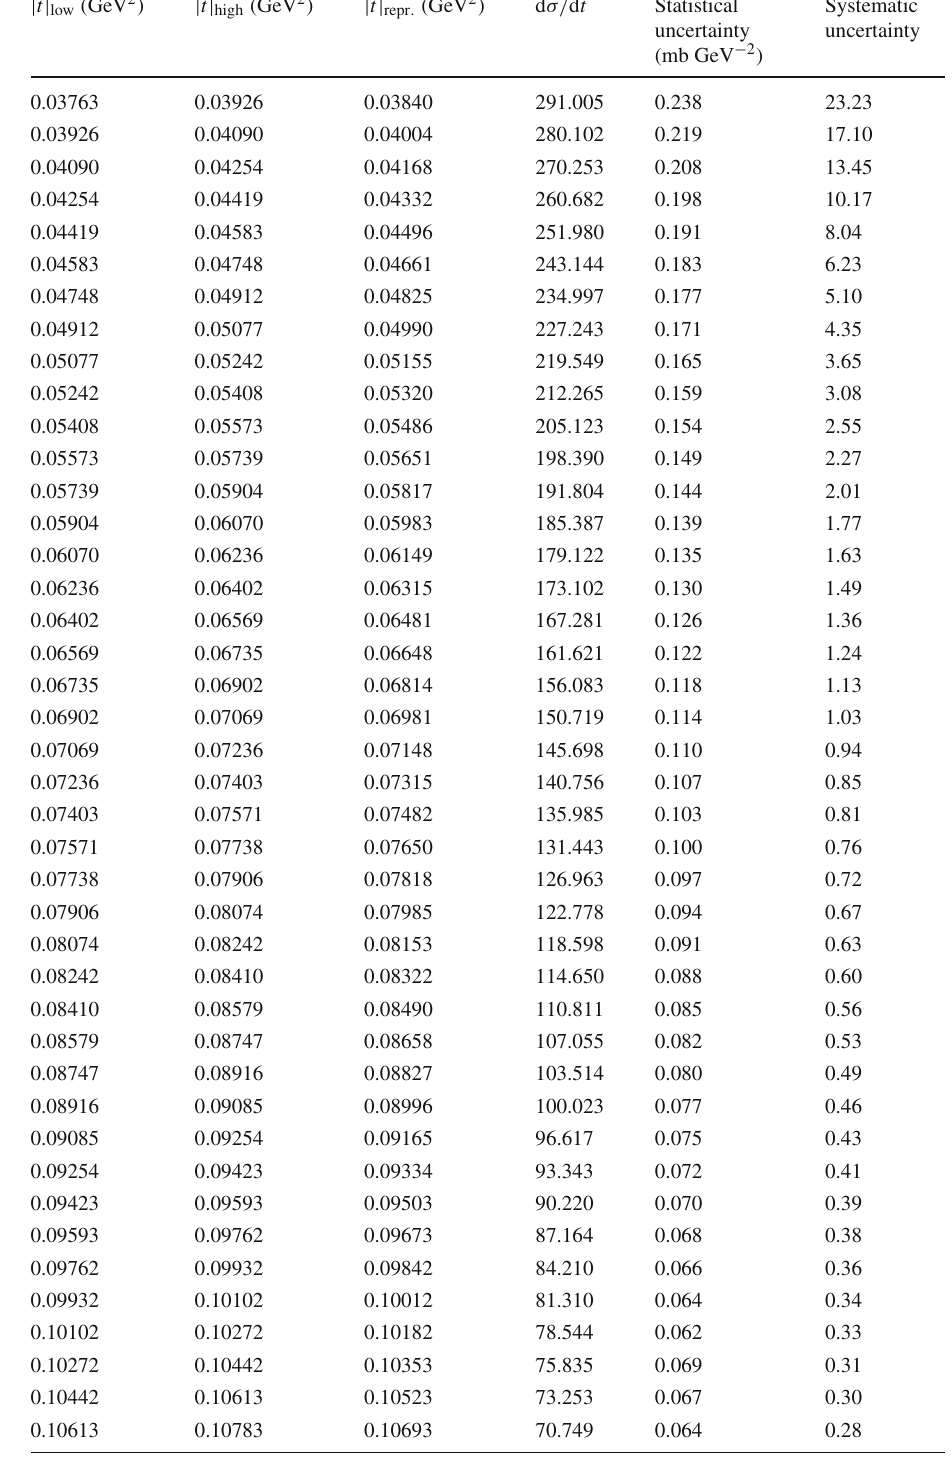
cross-section d σ/ d